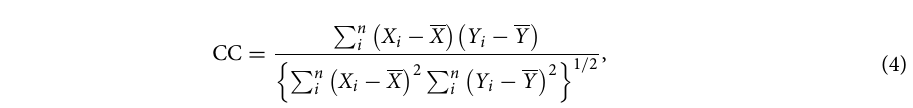
Figure 3. Training and validation data for CoreNet. ( a ) The EMNIST dataset is employed to train CoreNet. The custom dataset containing letters and patterns is employed to test CoreNet, and the letter “MST” and a smiling face are shown to demonstrate the performance of the network. CC, 2-D image correlation coefficient between the numerically reconstructed image and the original target image. ( b ) The phase modulation map for the lensless microendoscope of "MST" generated by GS, Core-GS, and